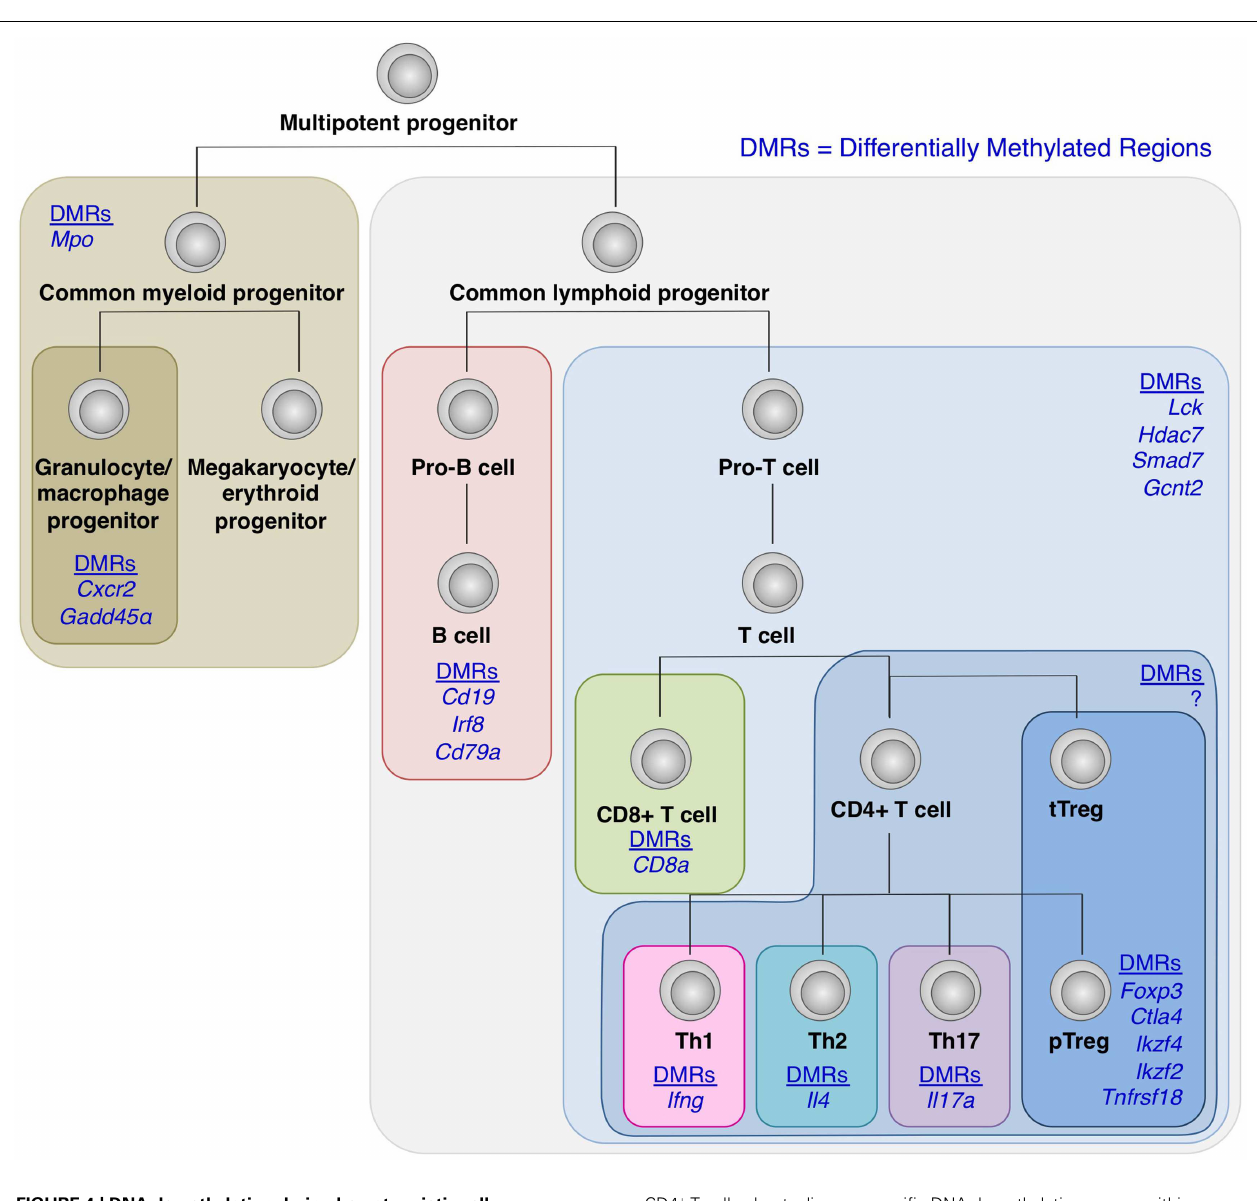
FIGURE 4 | DNA demethylation during hematopoietic cell differentiation . Differentially methylated regions (DMRs) tends to be detected within genes encoding molecules associated with lineage specification, such as Cxcr2 and Gadd45 α in granulocyte/macrophage progenitors; Cd19 , Irf8 , and Cd79 α in B cell lineage; and CD8a in CD8 + T cells (Ji et al., 2010; Bock et al., 2012; Lee et al., 2012). Similarly, within